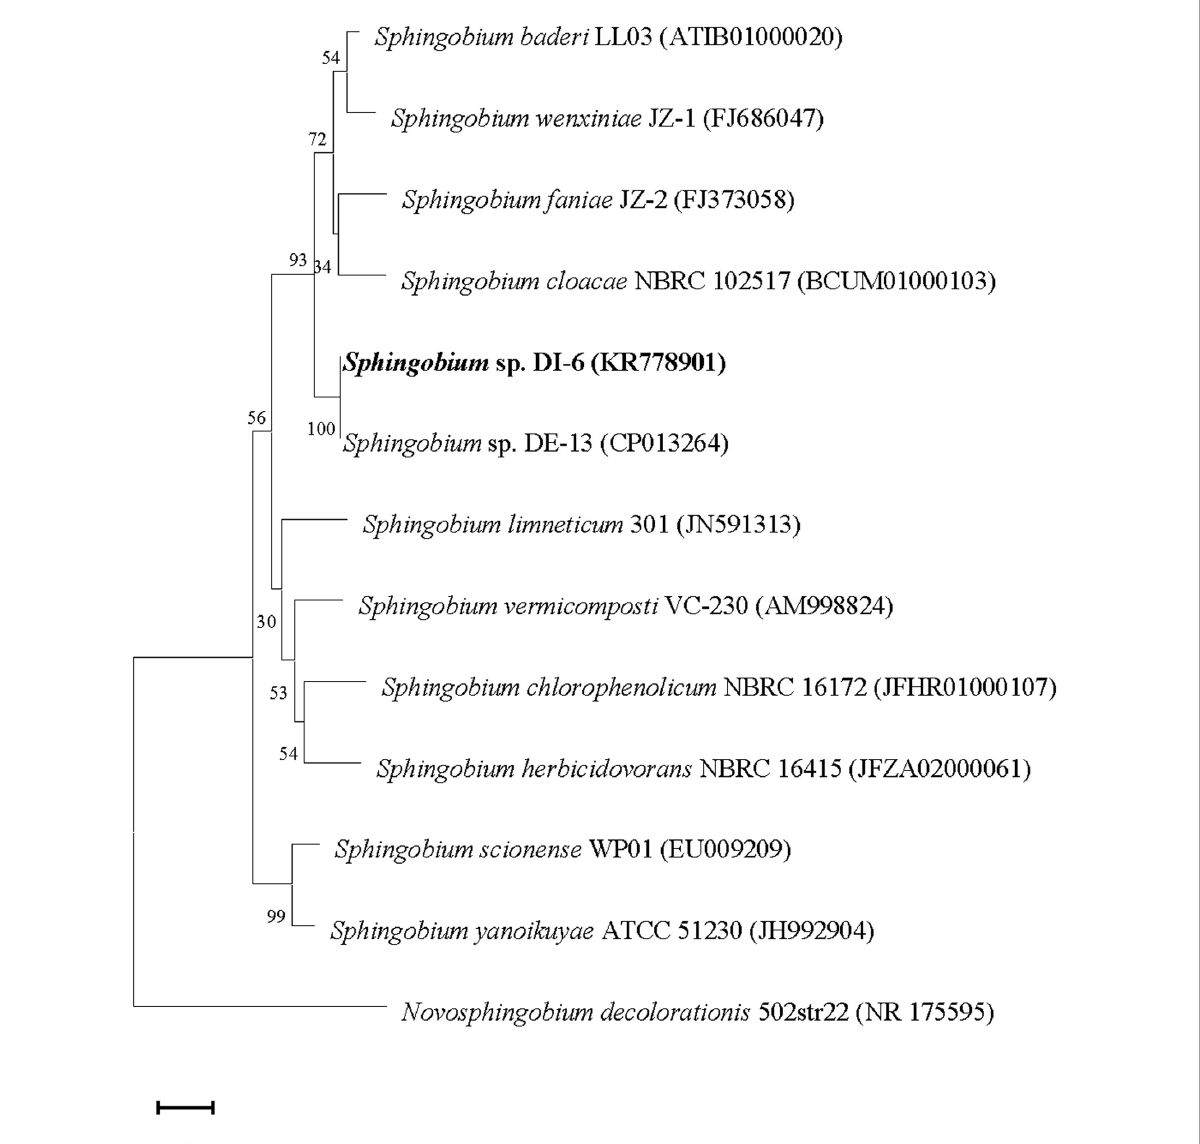
FIGURE1 Phylogenetic analysis of strain DI-6 and related species by the neighbor-joining approach. Bootstrap values obtained with 1,000 resamplings are indicated as percentages at all branches. A sequence of Novosphingobium decolorationis was used as the out-group. The scale bars represent 0.01 substitutions per nucleotide position. The GenBank accession number for each strain is shown in parentheses after the species